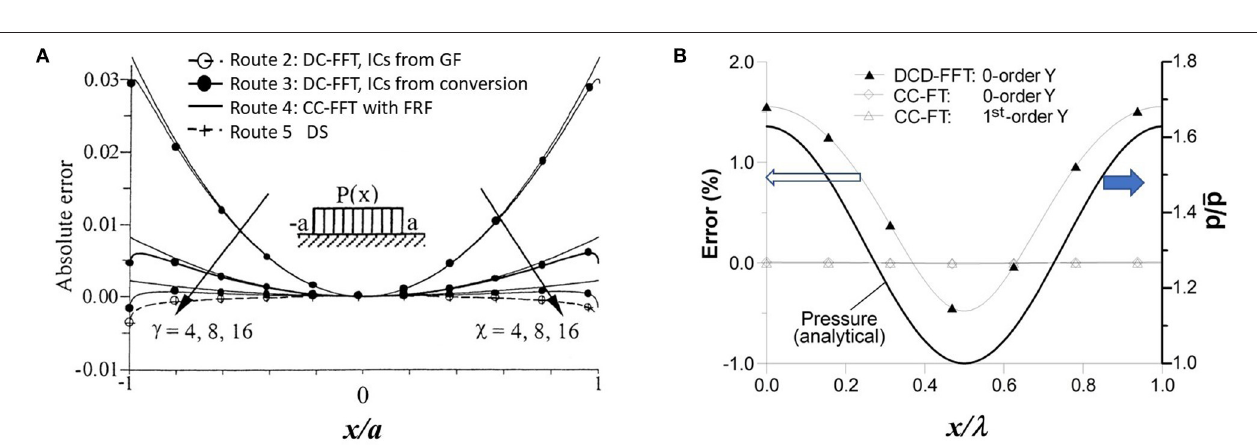
FIGURE 11 | Error comparisons. (A) DC-FFT and CC-FT algorithms in solving a finite-domain problem (Liu et al., 2000), Reprinted by permission from Elsevier, Wear , γ means the discretization density in the frequency domain and χ the ratio for spatial calculation domain extension, (B) CC-FT and DCD-FFT algorithms in solving the contact of a 3D sinusoidal wavy surface and a flat ( Liu S. et al., 2007), Reprinted by permission from Elsevier, Tribology International ; this is an infinite-domain, or periodic, problem. p means the average pressure.